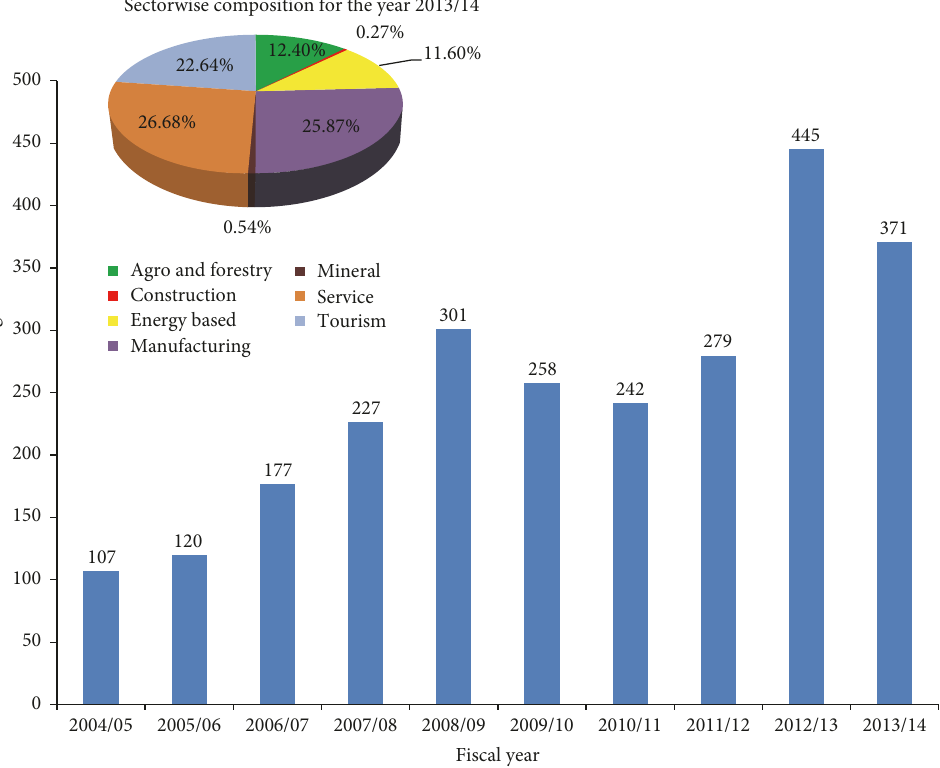
Figure 1: The increasing trend of industry registration in Nepal from the fiscal year 2004/05 to 2013/14, along with the sectorwise composition for the fiscal year 2013/14 (source: Department of Industry, GoN [8]).